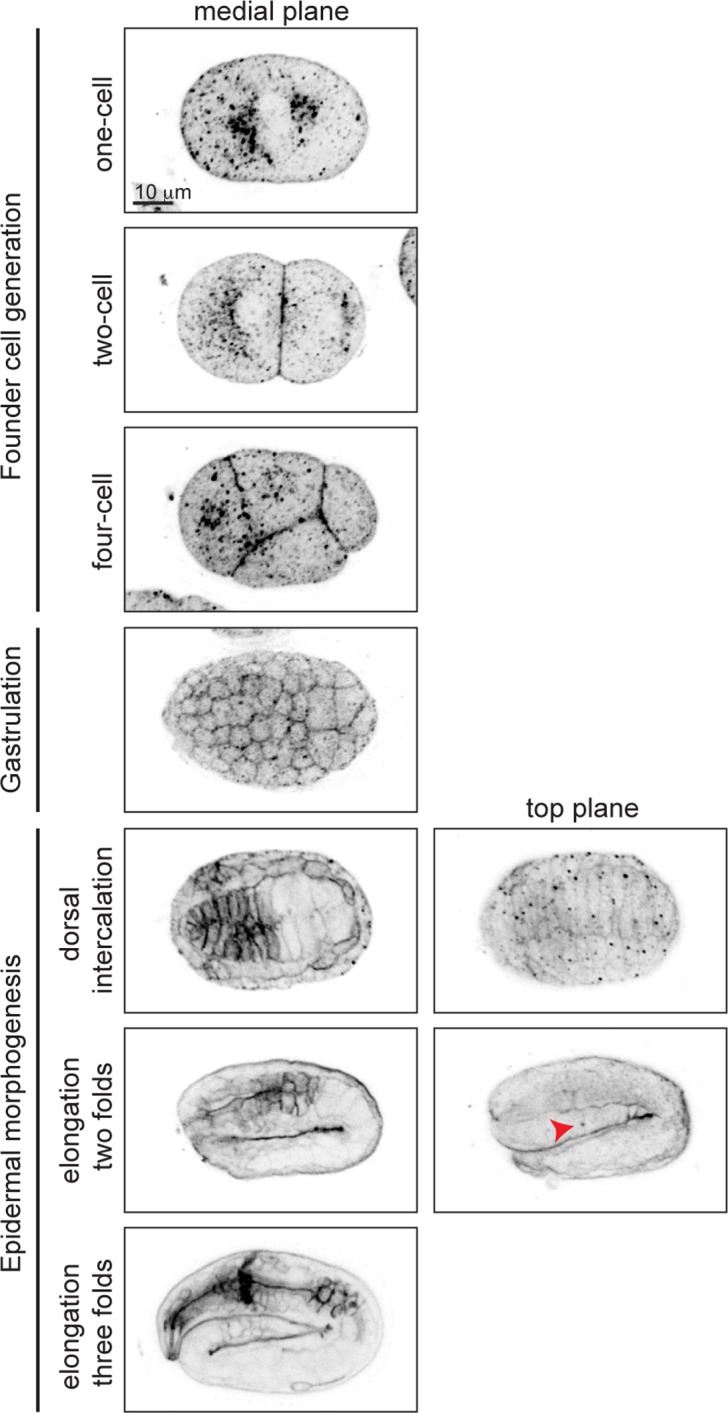
GPI-APs are present at the membrane throughout embryogenesis.Proaerolysin coupled to Alexa 488 (FLAER) was used to visualize GPI-APs in wild type embryos. GPI-APs are highly enriched at pharyngeal membranes, initially non-polarized, but then becomes polarized at the apical membrane during elongation. Red arrowhead denotes excretory canal.